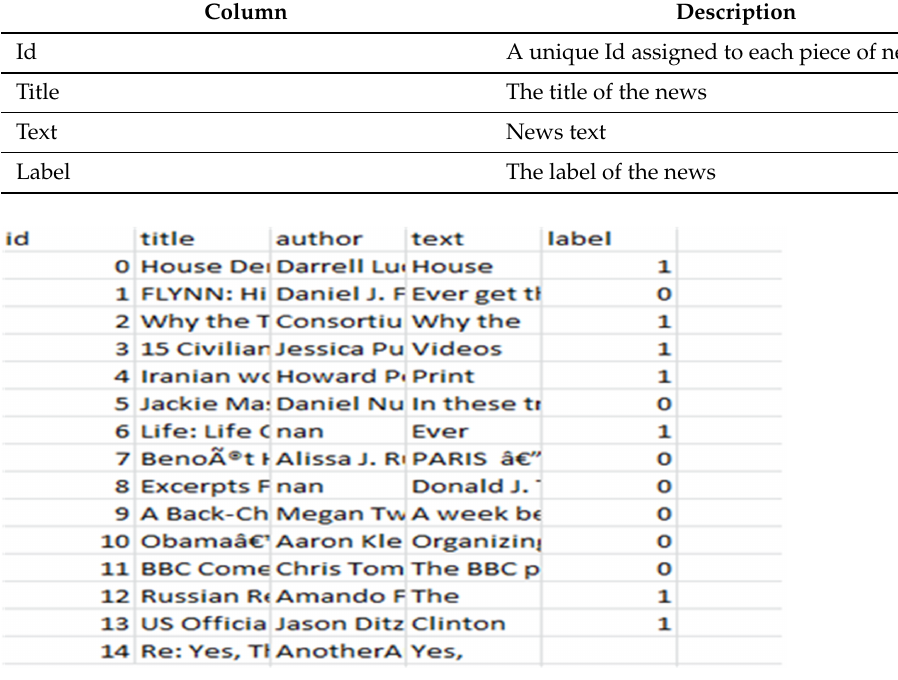
Figure 3. A snapshot of the